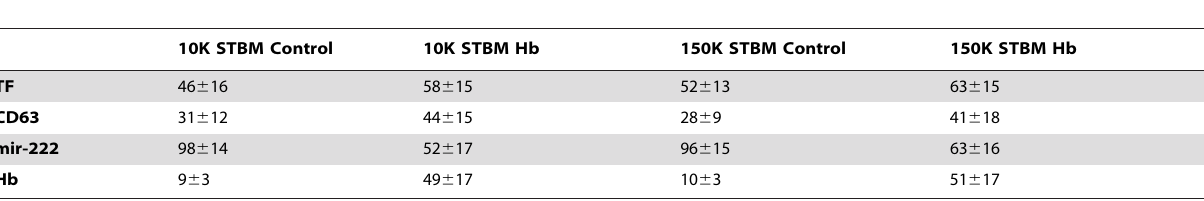
Table 2. Transmission electron microscopy (TEM) data, showing the amount of gold labels per square micrometre.